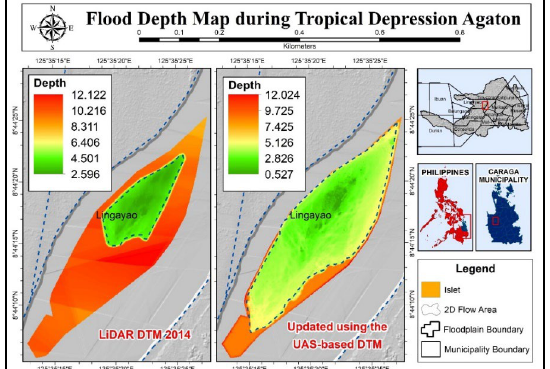
Figure 18. Comparison of flood depth maps using the existing LiDAR DTM and the updated data using UAS during the Tropical Depression Agaton.